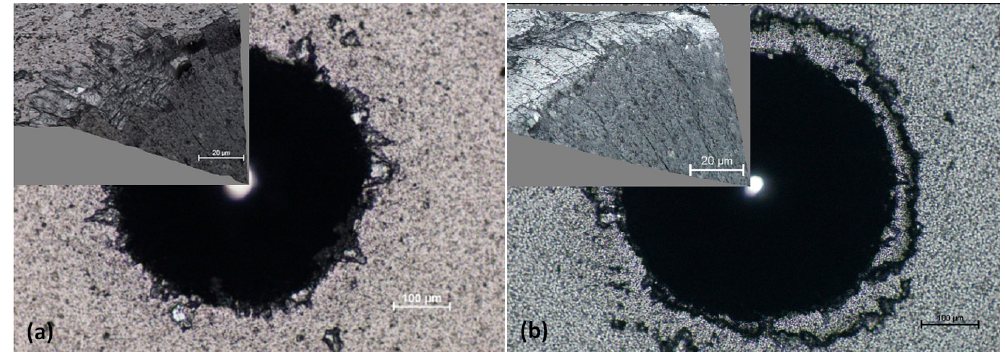
Figure 12. Micrographs of Rockwell indents in Daimler–Benz adhesion test for coatings, characterized by the highest scratch crack propagation resistance, deposited at: ( a ) 350 °C and 2 Pa and ( b ) 450 °C and 3